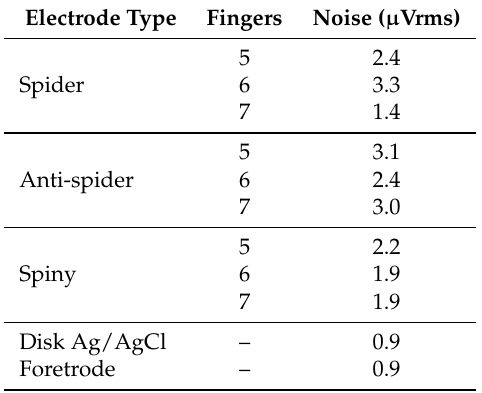
Table 4. Noise performance of the electrodes with a 0.3–100-Hz